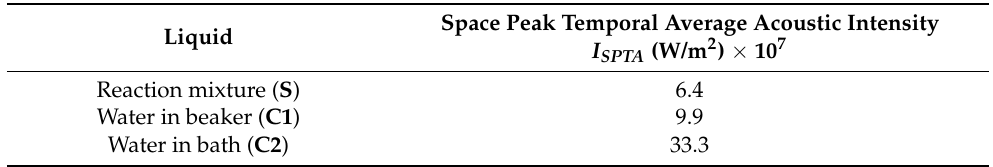
Table 3. Space peak temporal average acoustic intensity I SPTA in S , C1 , and C2 during ultrasound- assisted synthesis of